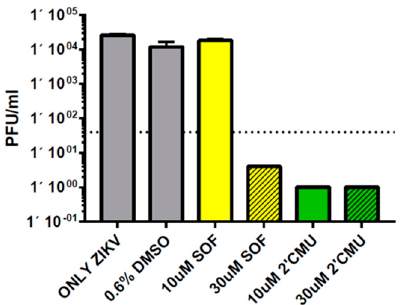
Figure 3. Reduction in ZIKV titers by 2 (cid:48) - C -methyluridine aryloxyl phosphoramidate ProTide and sofosbuvir in neural stem cells as observed by plaque assay. Viral infections were conducted in human fetal neural stem cells (H / PAN ZIKV, MOI 0.1) using vehicle-untreated (ONLY ZIKV), DMSO vehicle-treated, 10 or 30 µ M sofosbuvir (SOF)-treated, and 10 or 30 µ M 2 (cid:48) - C -methyluridine aryloxyl phosphoramidate ProTide (2 (cid:48) CMU)-treated samples. The dotted line represents the limit of detection of the assay. Virus was titered as described in the methods section and plaque forming units (PFU) per ml were calculated for each sample, ± standard error (SE), n = 4.